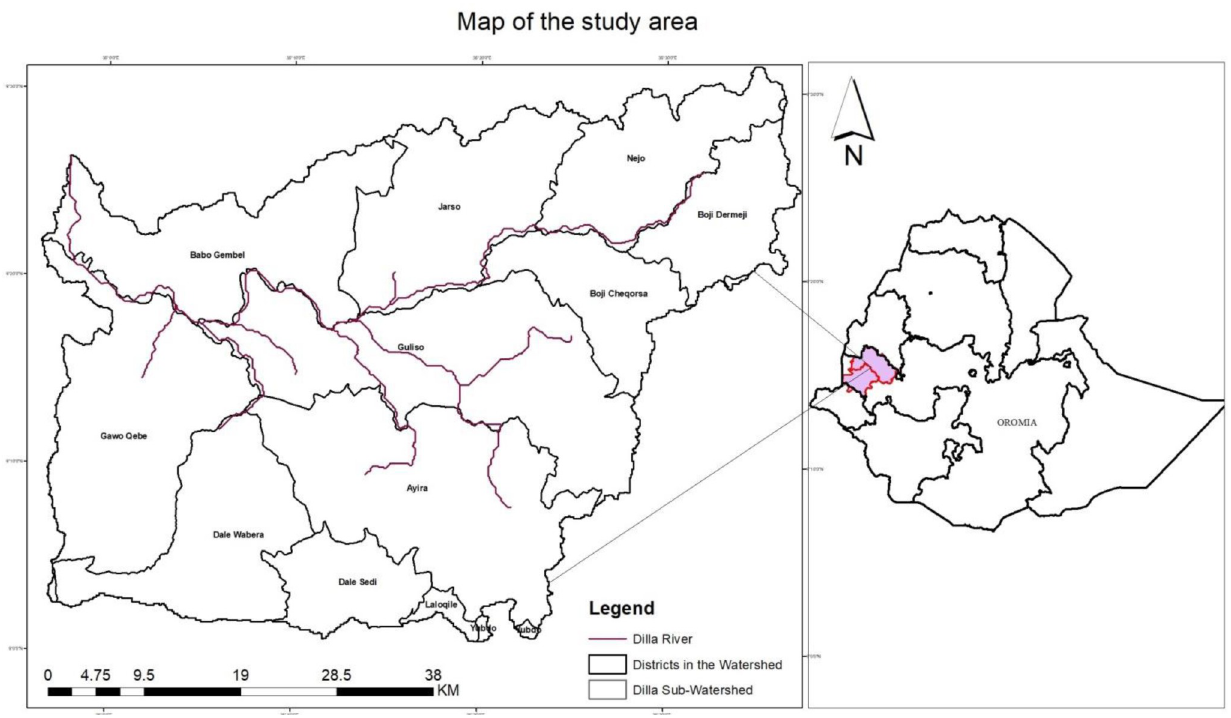
Fig 1. Map of the study area. Source: Ethiopian Central Statistical Agency.